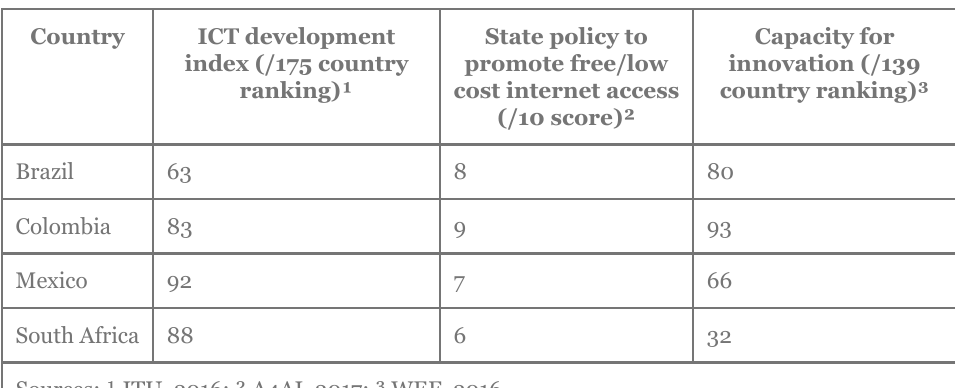
Table 5: Infrastructure and